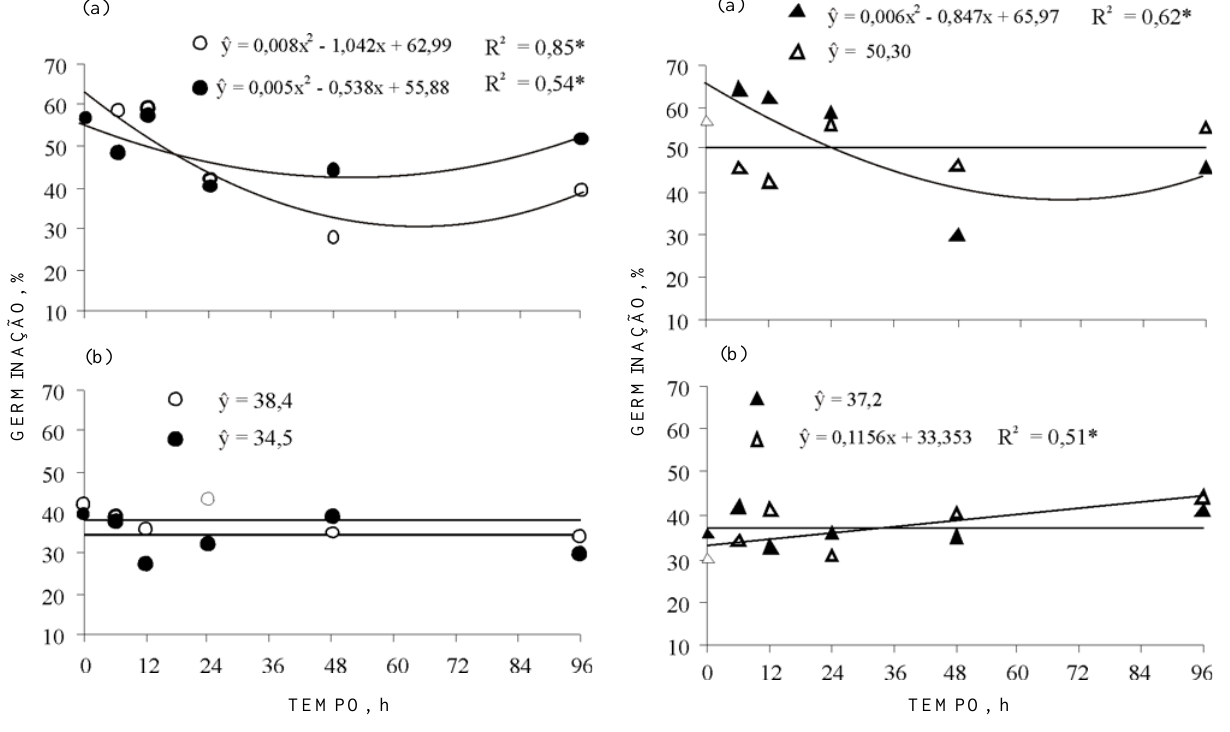
brizantha em razão do período de contato com superfosfato simples ( ) e superfosfato triplo (o), em condições de laboratório (a) e no solo